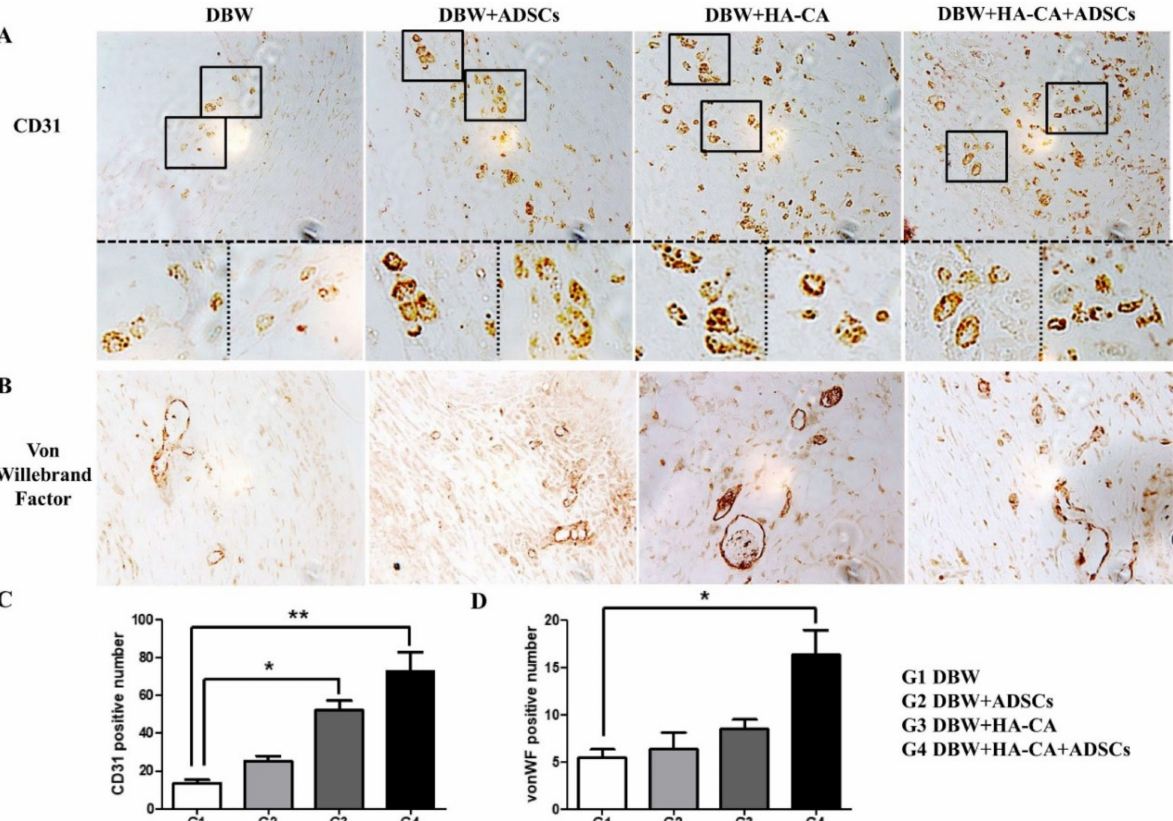
Figure 3. Immunohistochemical staining of the angiogenic markers cluster of differentiation 31 (CD31) and von willebrand factor (vWF). ( A ) Representative images of skin tissues showing positive staining for CD31 (brown) within the vessel structures in all groups. The number of CD31-positive vessels was higher in mice treated with HA-CA and HA-CA + ADSCs. ( B ) The number of vWF-positive vessels was extremely low in the control group, whereas mice in the HA-CA + ADSCs group had the greatest number of vWF-positive blood vessels. Magnification: × 400. ( C , D ) Bar graphs showing that mice in the HA-CA + ADSCs group had the greatest numbers of ( C ) CD31- and ( D ) vWF-positive vessels. Data are presented as means ± SEM (* p < 0.05, ** p < 0.01; n = 8–10 per